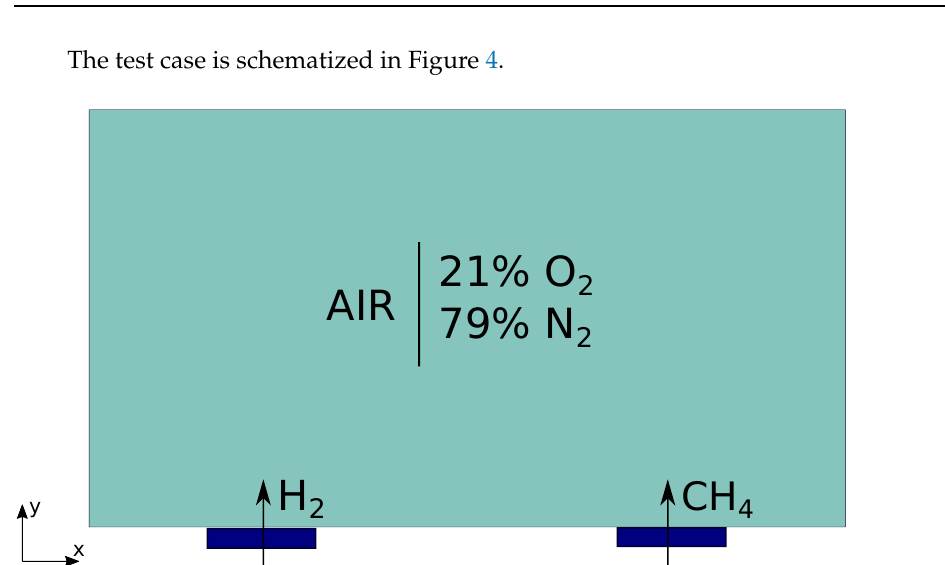
Figure 4. Illustration of the test case: methane and hydrogen are introduced, at initial time, at high temperature inside a domain of air. The combustion reactions for both species are